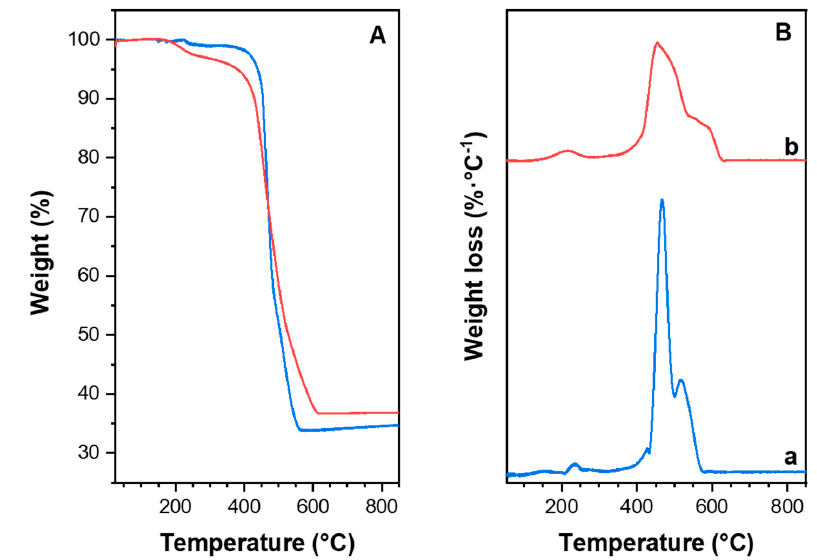
Figure 3. ( A ) Curves obtained from Thermal Gravimetric Analysis (TGA) measurements of ZIF-8 (blue line) and ZIF-8-HT (red line). ( B ) Weight loss curves from TGA measurements of ( a ) ZIF-8 and (b) ZIF-8-HT.